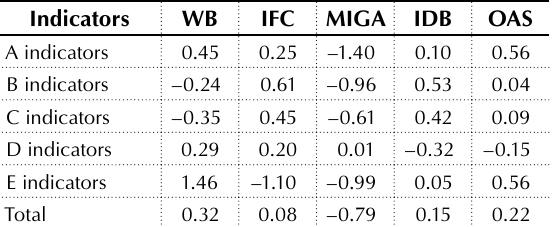
Table 14. Standardized results of the tool, by section and